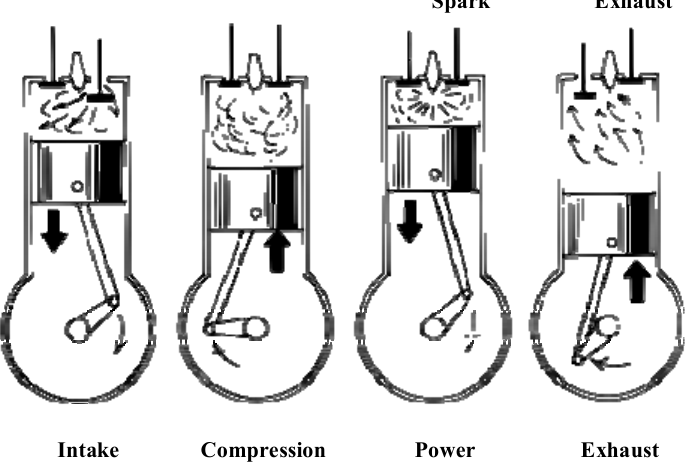
Figure 7. Four-stroke process of a reciprocating piston engine [59].